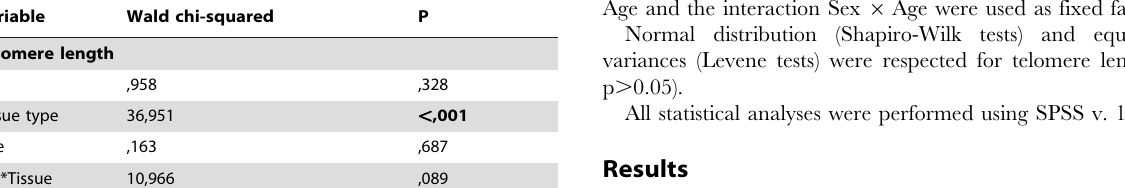
Age and the interaction Sex 6 Age were used as fixed factors.